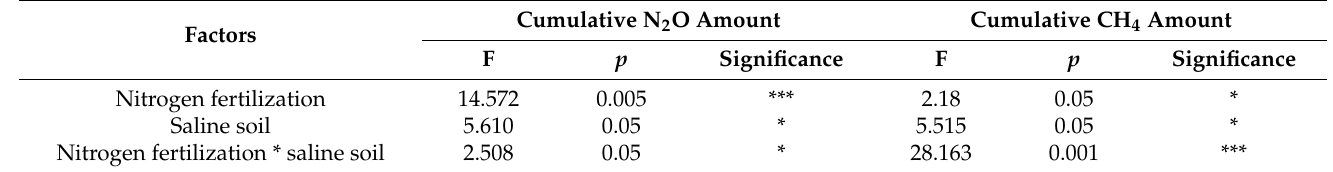
Figure 5. Pearson correlation analysis of CH 4 uptake and N 2 O emissions (n = 18, * p ≤ 0.05). EC: Electrical conductivity; NH 4+ -N: Ammonium; NO 3 − -N: Nitrate; T: Soil temperature; M: Soil moisture. Table 5. ANOVA for cumulative N 2 O and CH 4 from the interaction with different nitrogen fertilization–saline